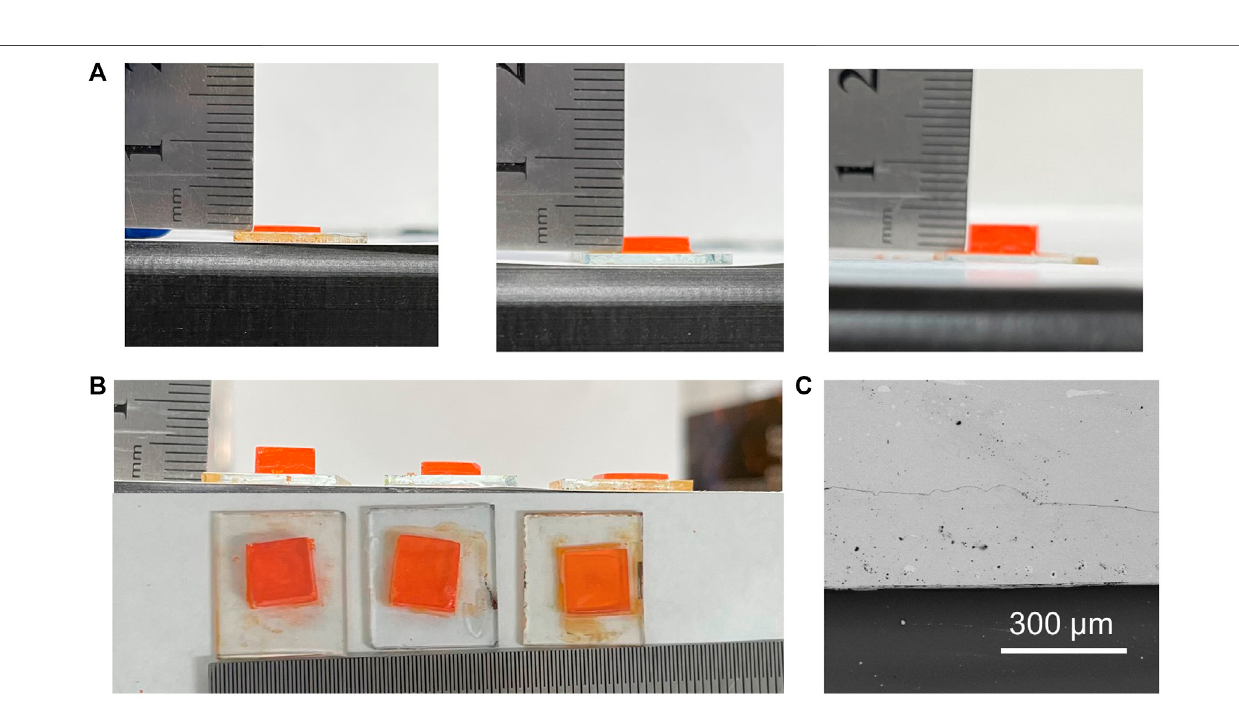
Frontiers in Chemistry |